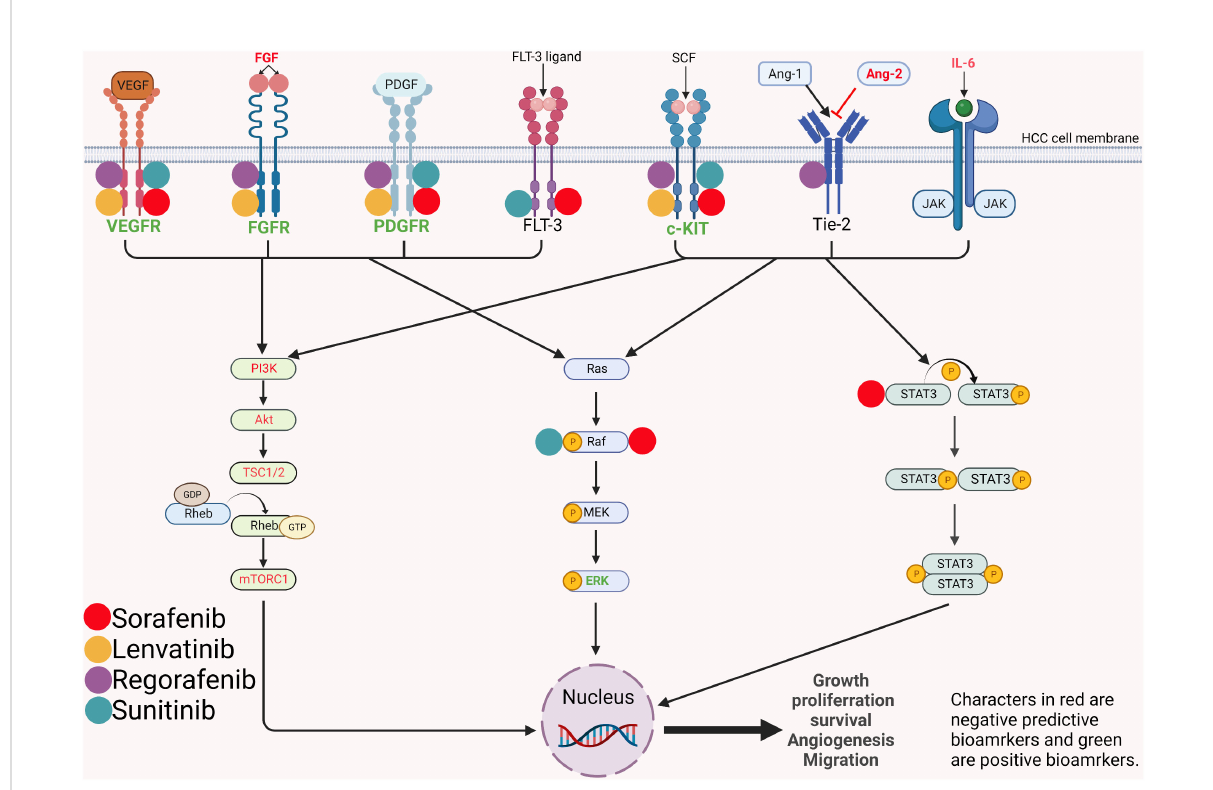
FIGURE 1 Mechanism and pathways involved in the angiogenesis and proliferation of hepatocellular carcinoma and potential predictive biomarkers. VEGFR, vascular endothelial growth factor receptor; FGFR, fi broblast growth factor; PDFGR, platelet-derived growth factor receptor; FLT-3, FMS-like tyrosine kinase 3; SCF, stem cell factor; Ang, angiopoietin; Tie2, tyrosine-protein kinase receptor; IL-6, interleukin-6; JAK, janus kinase; PI3K, phosphatidylinositol 3-kinase; Akt, protein kinase B; TSC, tuberous sclerosis complex subunit; Rheb, ras homolog enriched in brain; mTORC1, mammalian target of rapamycin complex 1; MEK, mitogen-activated protein kinase kinase; ERK, extracellular signal – regulated kinase; STAT, signal transducer and activator of